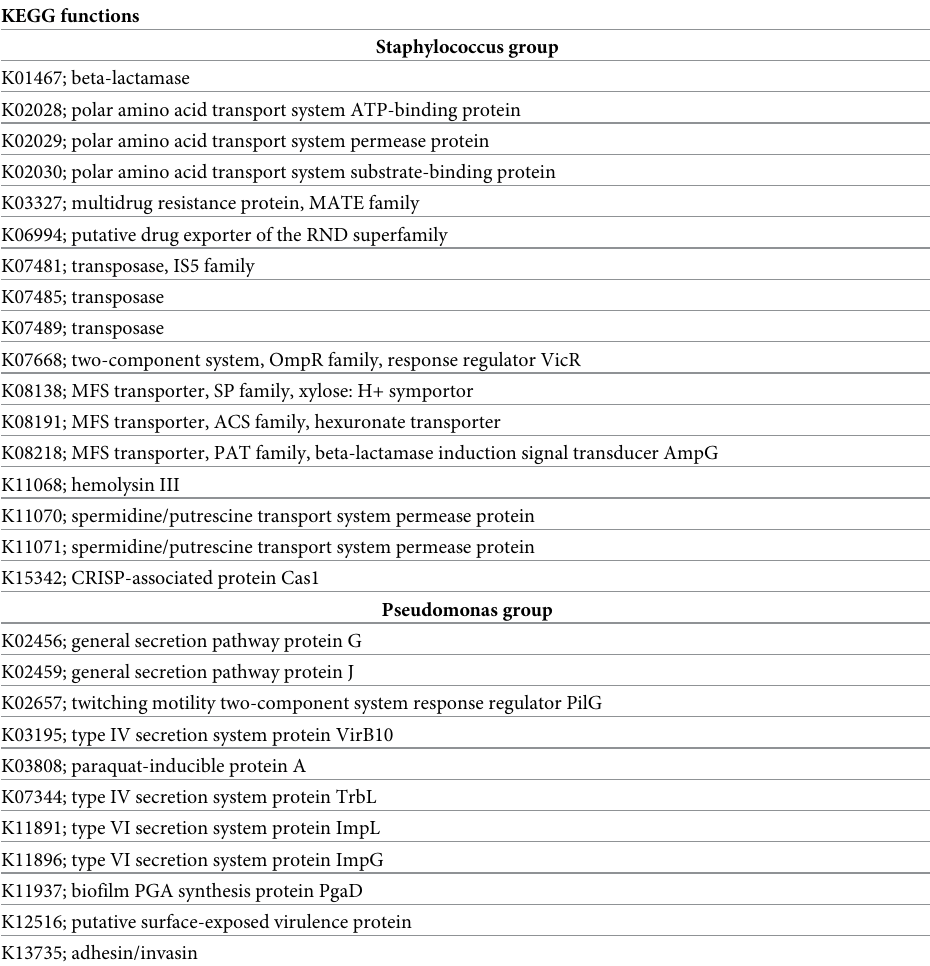
Table 1. Prediction of bacterial functional